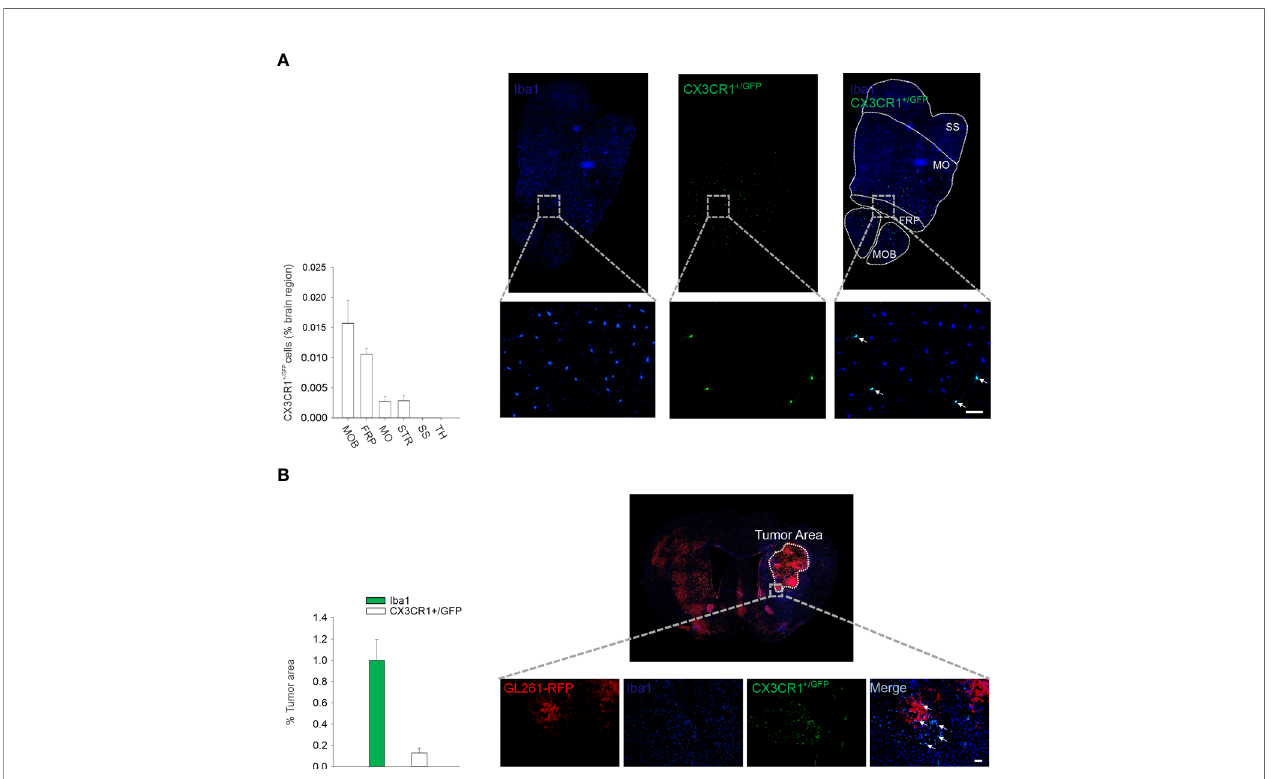
FIGURE 2 | Intranasal delivered microglia reachs glioma mass. (A) Migration of CX3CR1 +/GFP microglia in the brain of C57BL/6 mice after 3 days from i.n. delivery. Right: representative immuno fl uorescence of Iba1 (blu) and CX3CR1 +/GFP cells (green) in the transversal section of mouse brain (bottom: ×20 magni fi cation, scale bar 50 µm). MOB: main olfactory bulb; FRP: frontal pole; MO: somatomotor areas; STR: striatum; SS: somatosensory areas; TH: thalamus. Left: the mean (± s.e.m.) area of CX3CR1 +/GFP cells in different brain regions (as % of the area) in C57BL/6 male mice (n = 3). (B) Intranasal delivery of microglia (CX3CR1 +/GFP ) in GBM- bearing mice. Right: representative immuno fl uorescence of Iba1 (microglia/macrophage marker, in blue) and CX3CR1 +/GFP cells (intranasally delivered microglia expressing CX3CR1 receptor in green) in coronal sections, 17 days after GL261 implantation in mice (scale bar: 50 µm). Red: tagRFP-GL261 cells. Left: the mean (± – s.e.m.) area covered by Iba1 and CX3CR1 +/GFP cells in the tumor area in tagRFP-GL261-bearing mice (n =